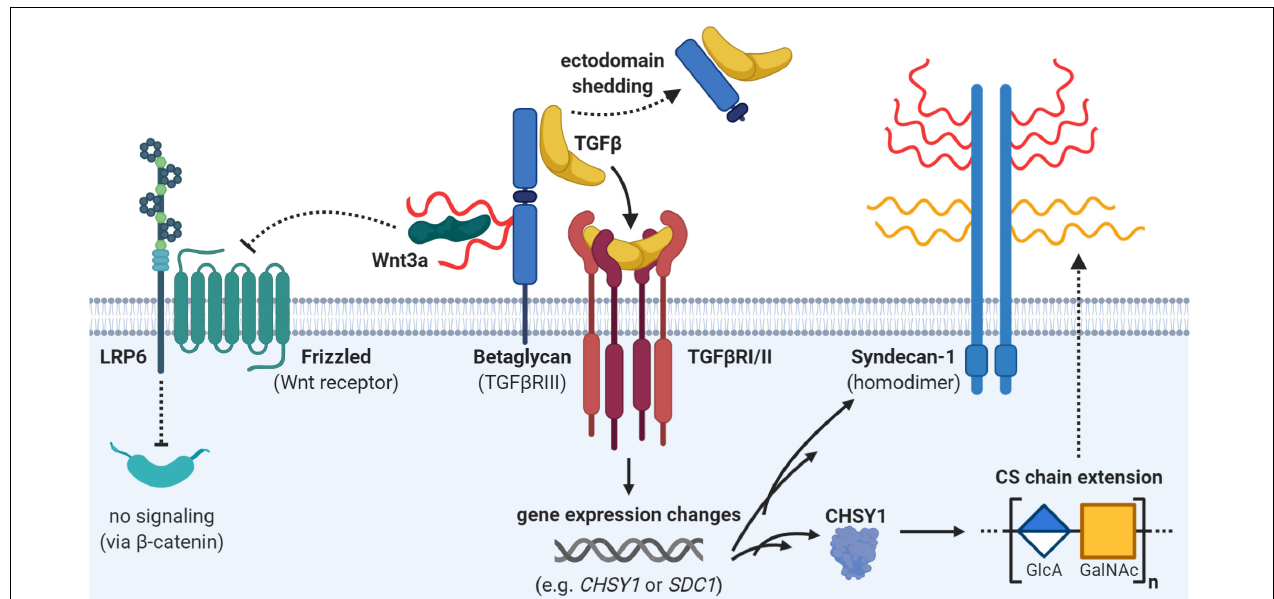
FIGURE 4 | Interplay of proteoglycans and transforming growth factor beta (TGF β ) signaling. The proteoglycan betaglycan is a co-receptor for TGF β and brings it to the TGF β receptor (heterodimer of TGF β RI and TGF β RII). However, ectodomain shedding of betaglycan might attenuate TGF β signaling. Furthermore, betaglycan also dampens Wnt signaling by sequestering Wnt ligands with its heparan sulfate (HS) side chains (in red). Active TGF β signaling can affect the expression of many different genes such as SDC1 or CHSY1 . Upregulation of the enzyme chondroitin sulfate synthase 1 (CHSY1) can potentially lead to elongation of chondroitin sulfate (CS) chains on proteoglycans. Indeed, TGF β can also upregulate one potential CHSY1 targets, namely syndecan-1, which can carry both chondroitin sulfate (CS; in yellow) or heparan sulfate (HS; in red). Details and references are provided in the main